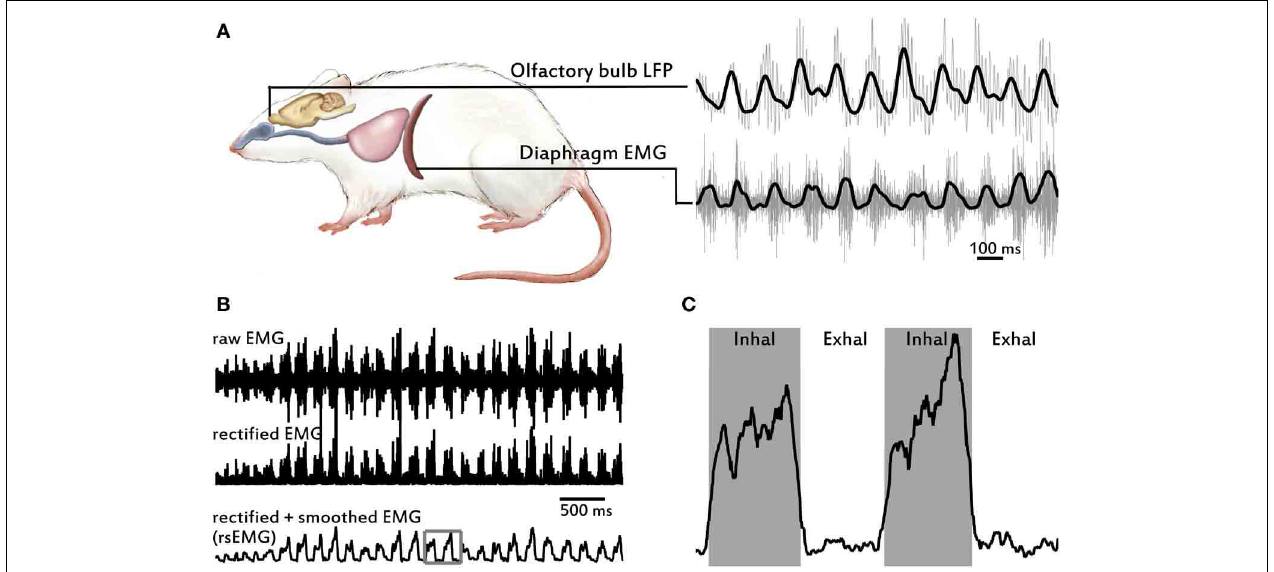
FIGURE 1 | Overview of signals recorded and EMG processing to obtain respiratory variables. (A) Drawing of a rat showing the two structures and signals recorded: the local field potential (LFP) from the olfactory bulb (OB) in the brain (top trace), and the electromyogram (EMG) from the diaphragm (bottom trace). Respiratory airways from the nose to the lungs are also depicted. Gray traces correspond to raw